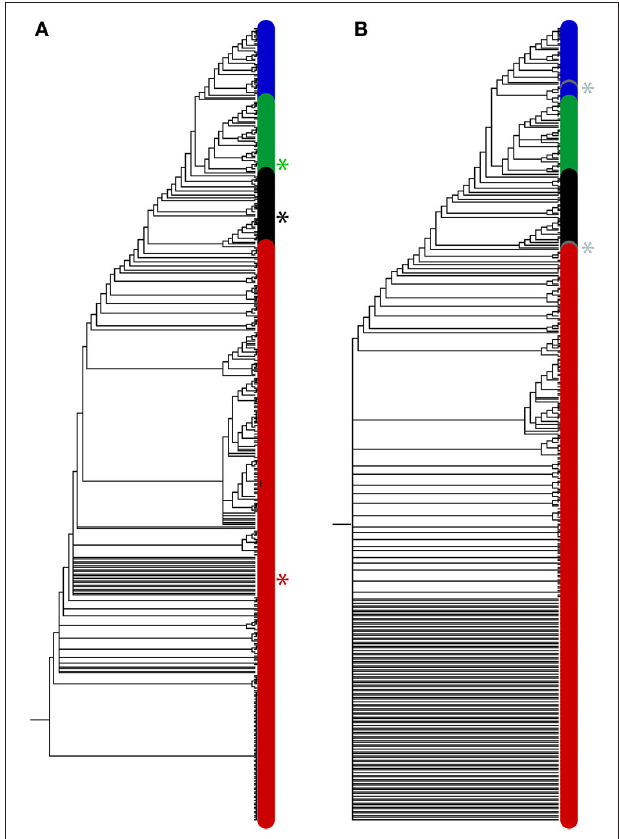
FIGURE 3 | Trees of proteomes are robust and insensitive to the effects of genome size but sensitive to holobiont relationships defining taxa. (A) The single most parsimonious tree (taxa = 368; characters = 442; length = 45,935, retention index = 0.83, g 1 = − 0.31) describing the evolution of 102 cellular organisms (34 each from Archaea, Bacteria, and Eukarya) and 266 viruses (sampled at least 5 viruses from each family/order) ( Nasir and Caetano-Anollés, 2015 ). The smallest proteomes for cells ( I. hospitalis and A. gossypii ; black and green asterisks) and viruses (bat cycloviruses; red asterisk) are indicated. The names of taxa are not shown because they would not be visible. Instead, the positions of terminals were colored according to supergroup, green (Eukarya), blue (Bacteria), black (Archaea) and red (viruses). (B) A strict consensus of two most parsimonious trees (length = 46,781, retention index = 0.83, g 1 = − 19.81 and − 19.82) built using phylogenomic data from the 368 proteomes of panel (A) plus the proteomes from the two extremely reduced R. prowazekii and N. equitans (gray circles and asterisks). While no major topological distortions are observed, the consensus tree losses resolution at its